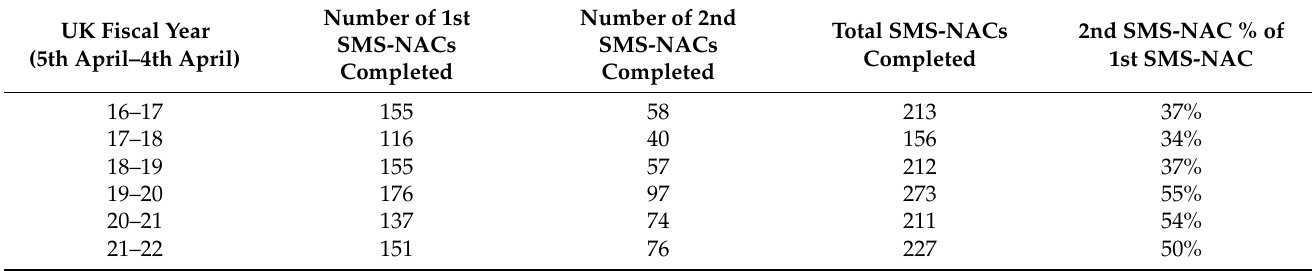
Table 5. Annual report data from FY16–17 to FY21–22 show the number of first SMS-NACs completed, the number of second SMS-NACs completed, and the percentage proportion of second SMS-NACs completed by first SMS-NACs.